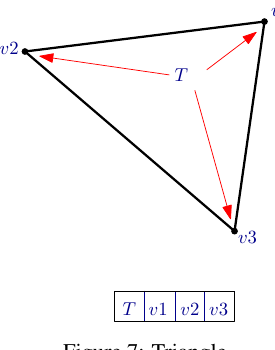
Figure 5: Constrained Delaunay Triangulation of point set and